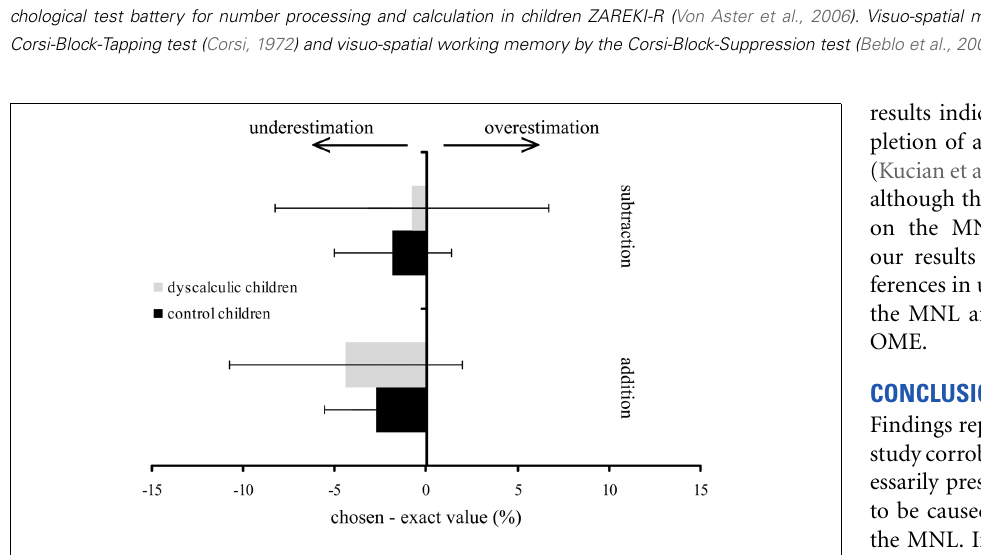
FIGURE 1 | Operational momentum effect in children with developmental dyscalculia and controls. Mean difference between chosen and exact value on a number line from 0–100 of children with (gray) and without DD (black). Negative values indicate an underestimation and positive values an overestimation of the position on the number